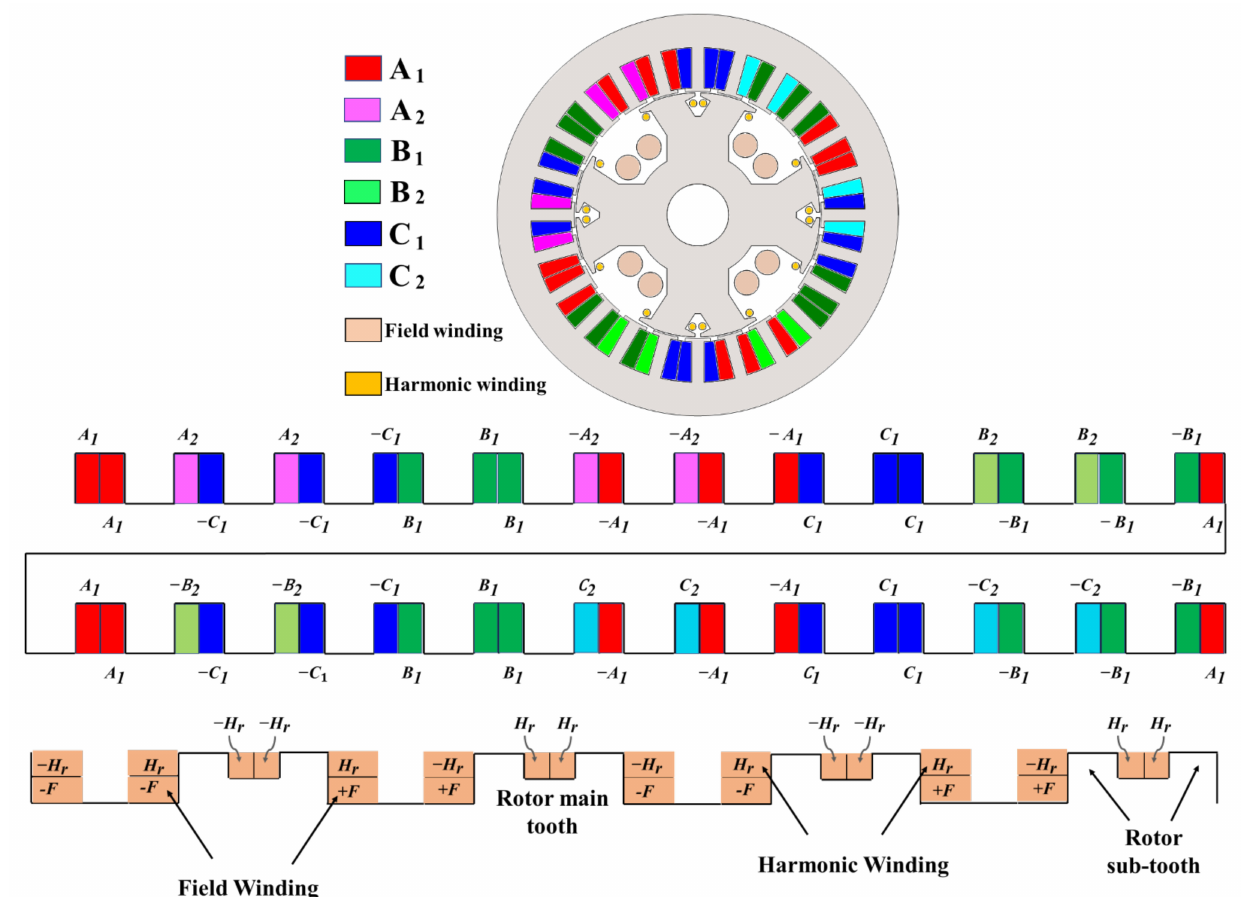
Figure 6. Armature and rotor winding configurations employed for the proposed BL-WRSM topology based on sub- harmonic field-excitation